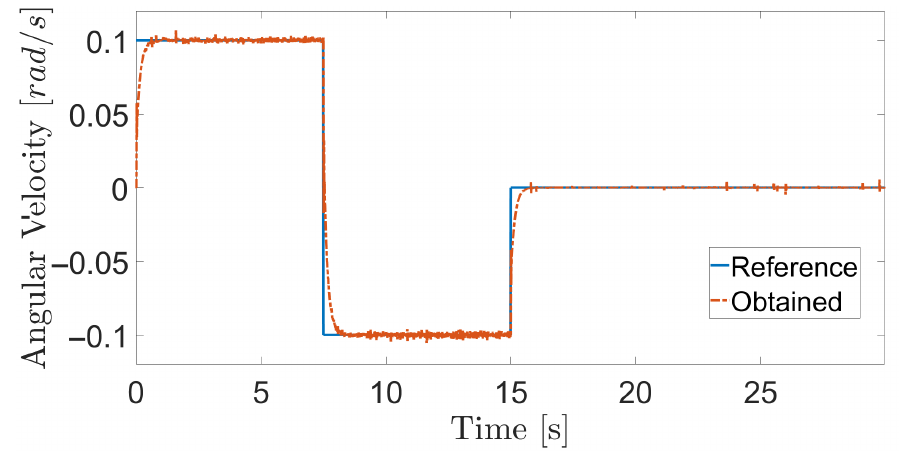
Figure 13. Angular velocity in the PI controller during navigation of the climbing robot in the storage tank.